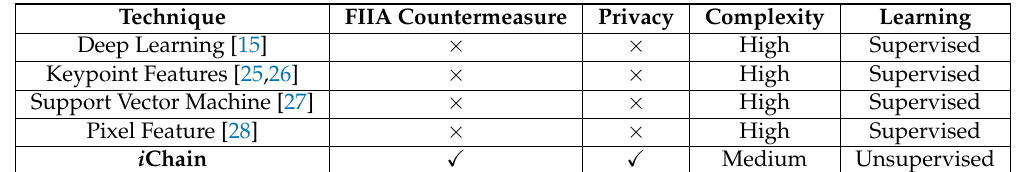
Table 1. Comparison among image tampering techniques